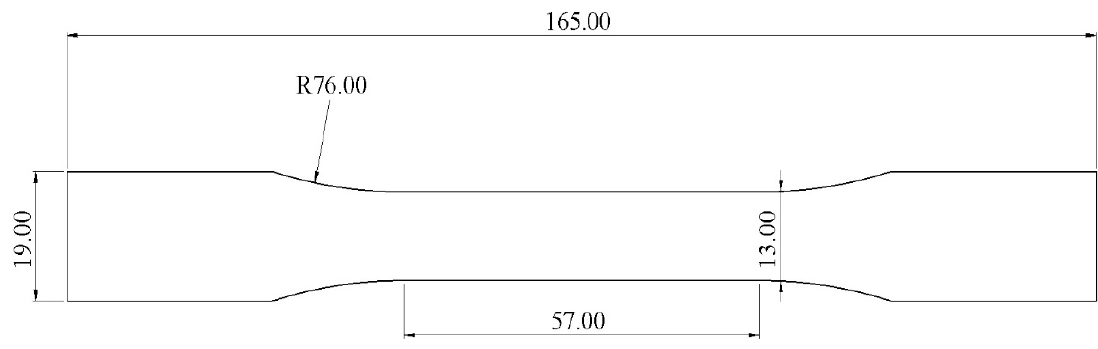
Figure 4. Computer aided design ( CAD) design of dog-bone shaped sample.